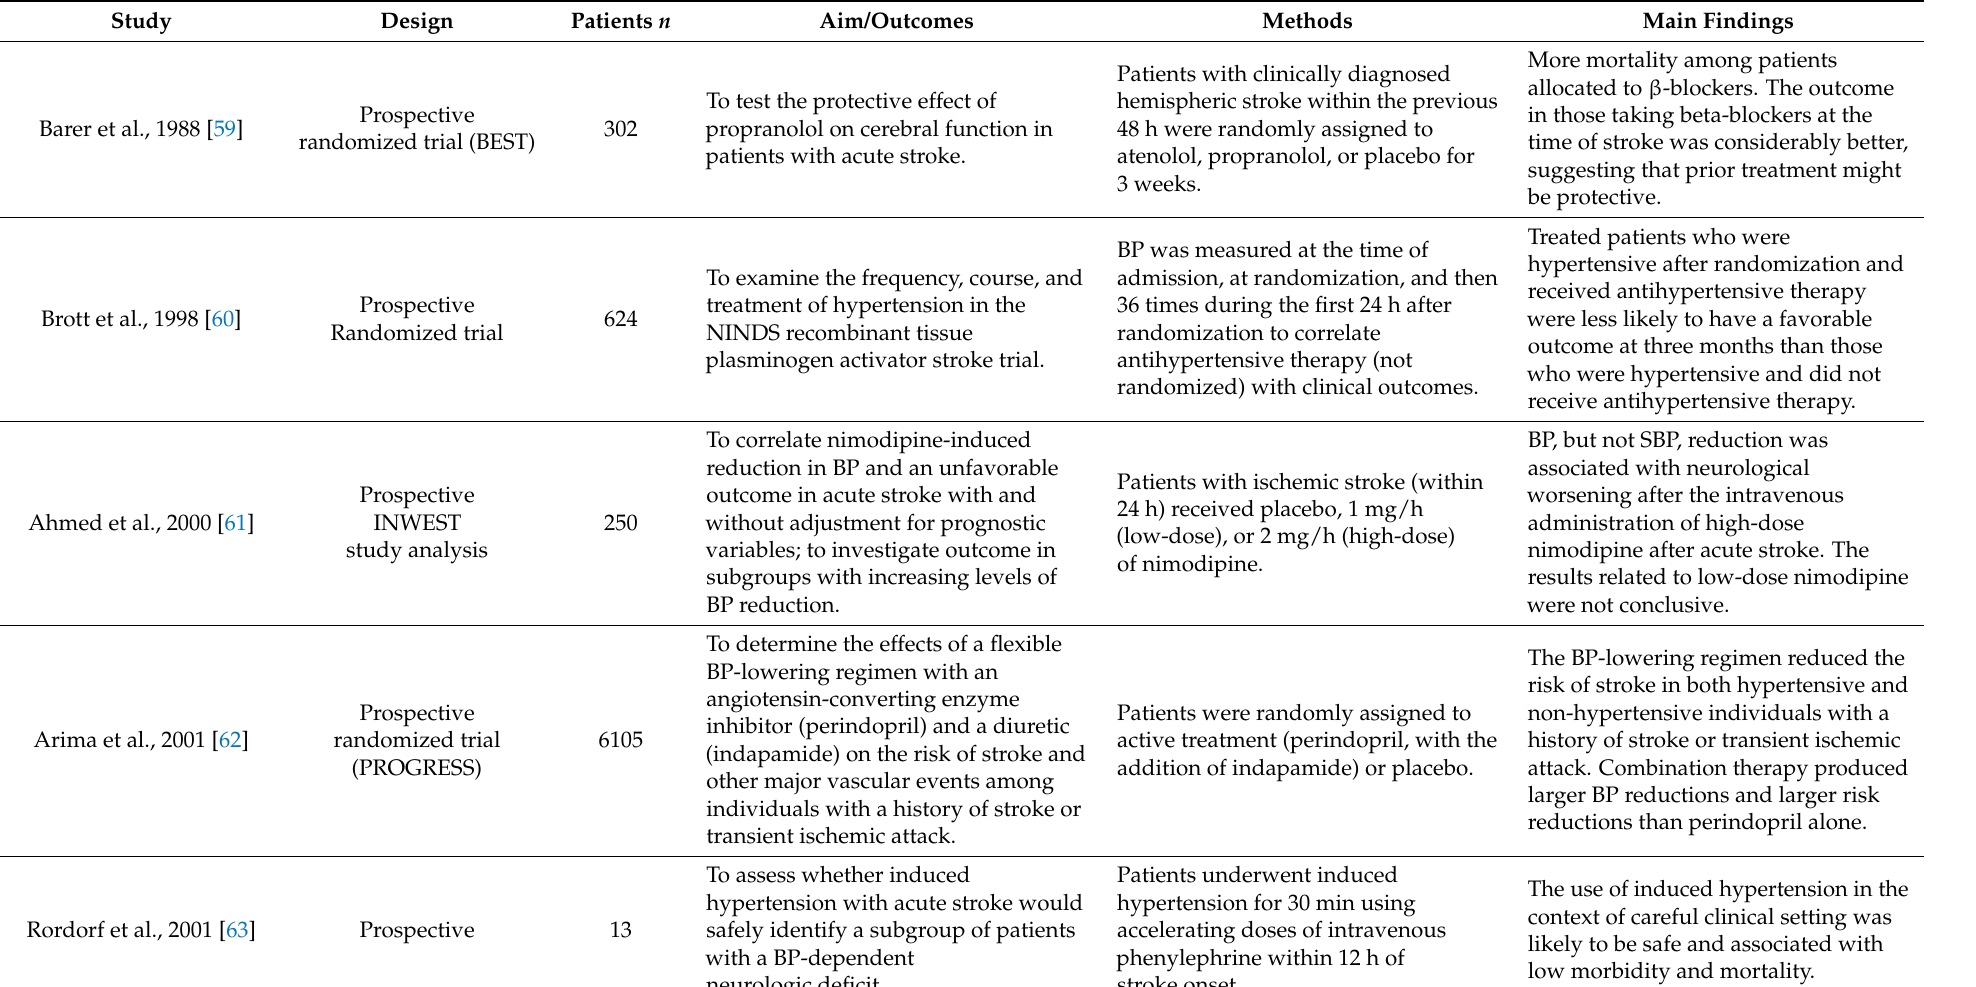
Table 1. Relevant studies on hypertensive crisis and ischemic